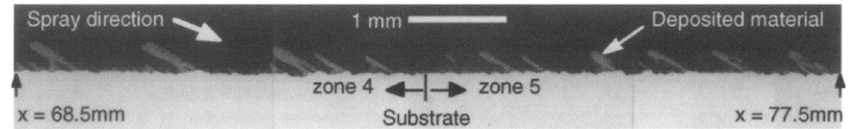
Figure 24. Micrograph of an APS coating in the over-sprayed area showing inclined columns [29].